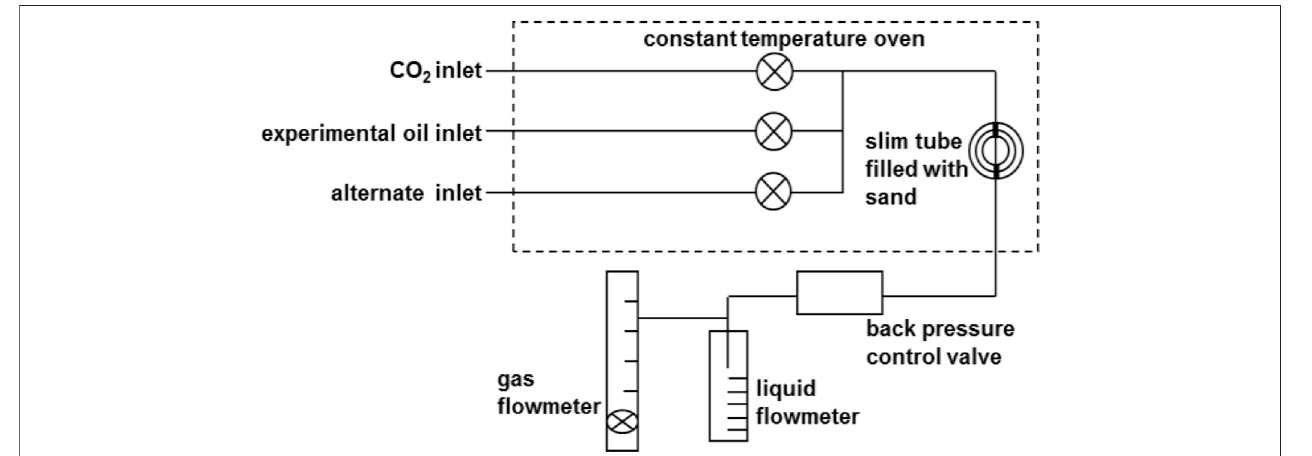
FIGURE 1 | The sketch of long-slim-tube displacement experimental apparatus.